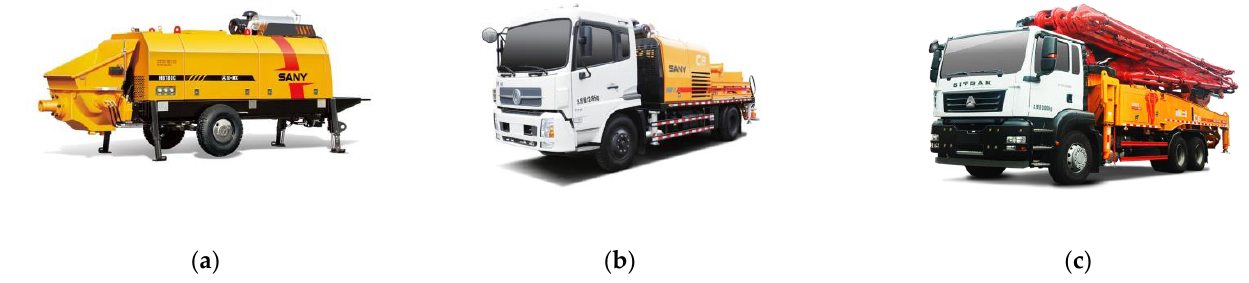
Figure 1. The basic research process.